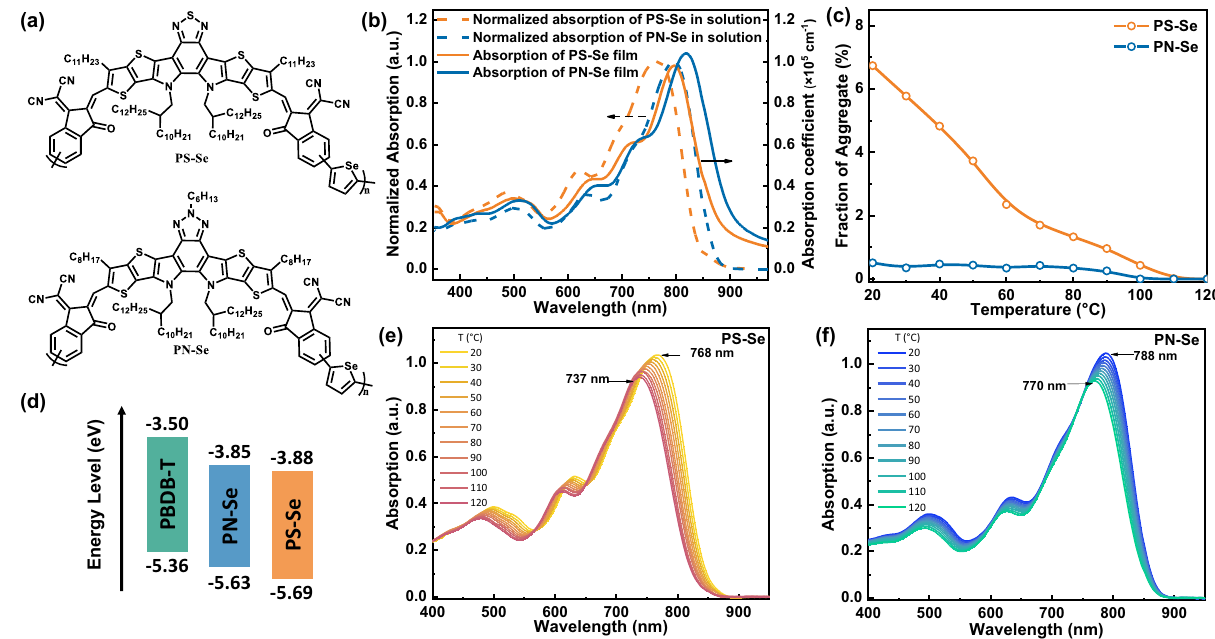
Fig. 1 Molecular structures and physicochemical properties of PS-Se and PN-Se. a Chemical structures of PS-Se and PN-Se acceptors. b UV-vis absorption spectra of PS-Se and PN-Se in chloroform solutions and the corresponding neat fi lms. c Plots of calculated aggregate content (molar %) of the two polymer acceptors in chlorobenzene at different temperatures. d Energy level diagram of the related materials in the all-PSCs. Variable-temperature UV-vis absorption spectra of ( e ) PS-Se and ( f ) PN-Se in